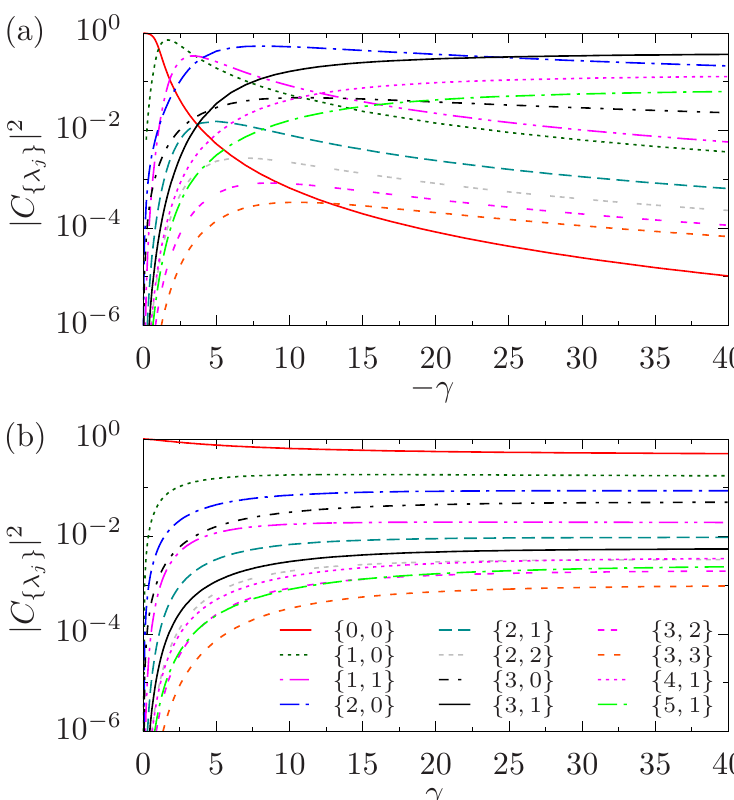
| 2 of the lowest-energy Lieb–Liniger eigenstates for quenches of Figure 3: Populations | C { λ } j the interaction strength from zero to γ and N = 4 particles. (a) Populations for attractive } = { 3,1 } , { 4,1 } , and { 5,1 } postquench interaction strengths. All states except those with { n j contain bound states (i.e., have some complex rapidities). See the detailed discussion of bound states in Sec. 4.1, as well as Fig. 4. (b) Populations for repulsive postquench inter- action strengths for comparison with